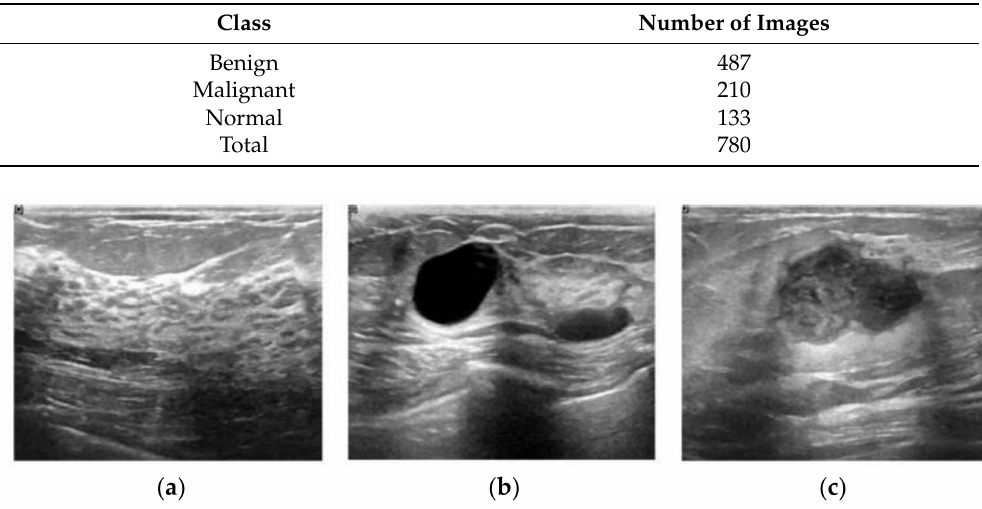
Figure 1. Sample B-mode images of the breast ultrasounddataset [11]; ( a ) Normal, ( b ) benign, and ( c )